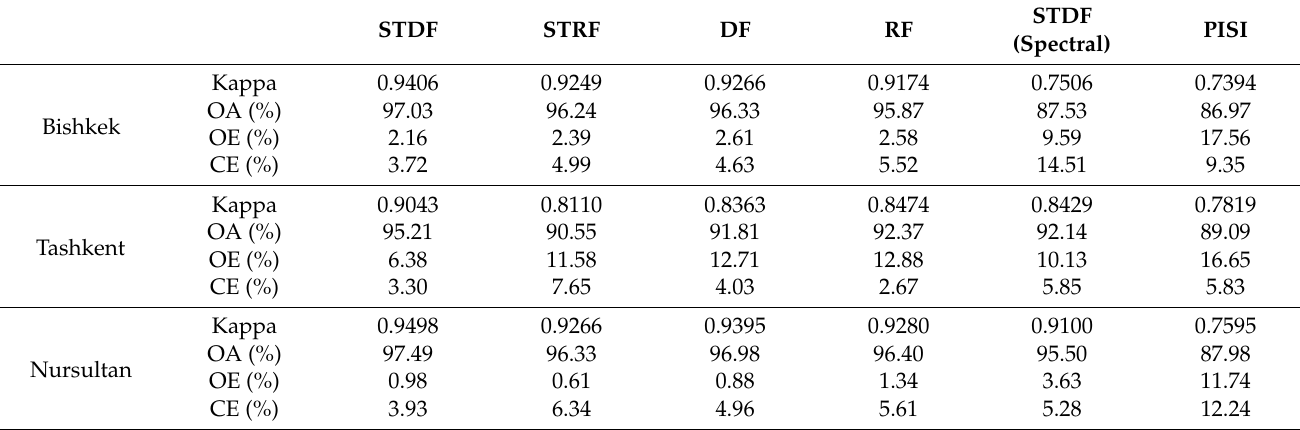
Table 3. Classification accuracy results for six